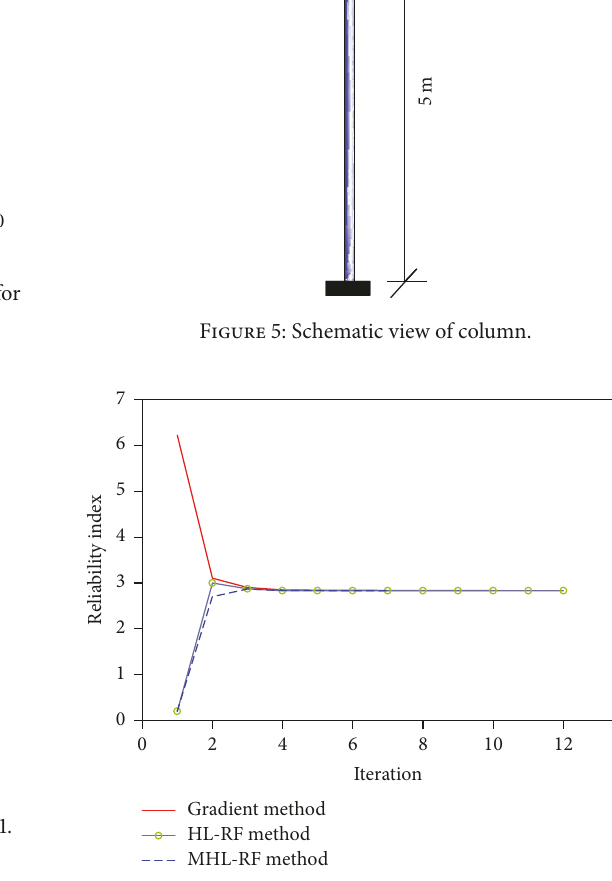
Figure 6: Reliability histories of different reliability method for column